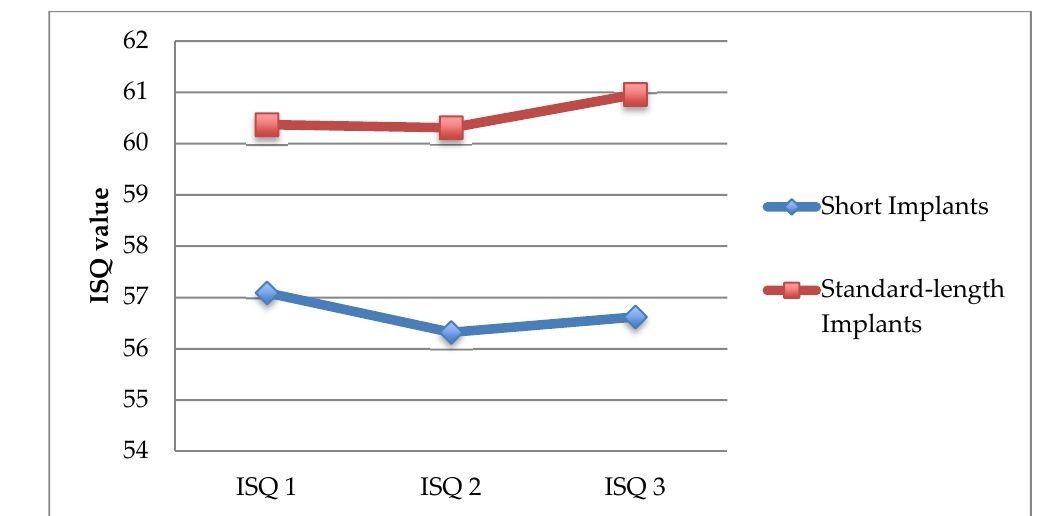
Figure 2. Changes in mean ISQ values of patients with standard implants ( ≥ 10 mm) and short implants (7 and 8.5 mm). Table 2. Comparison of ISQ increases between short and standard implants at the three follow-up time points. Short Implants ( n = 47) Standard Implants ( n = Time of Follow-Up Mean ± SD